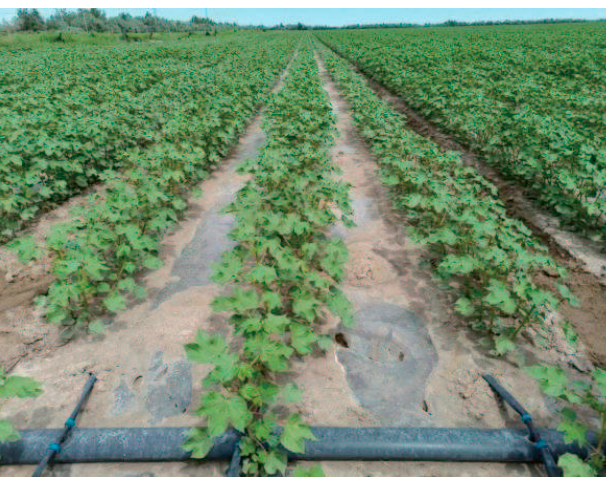
Figure 3. Experimental cotton field.